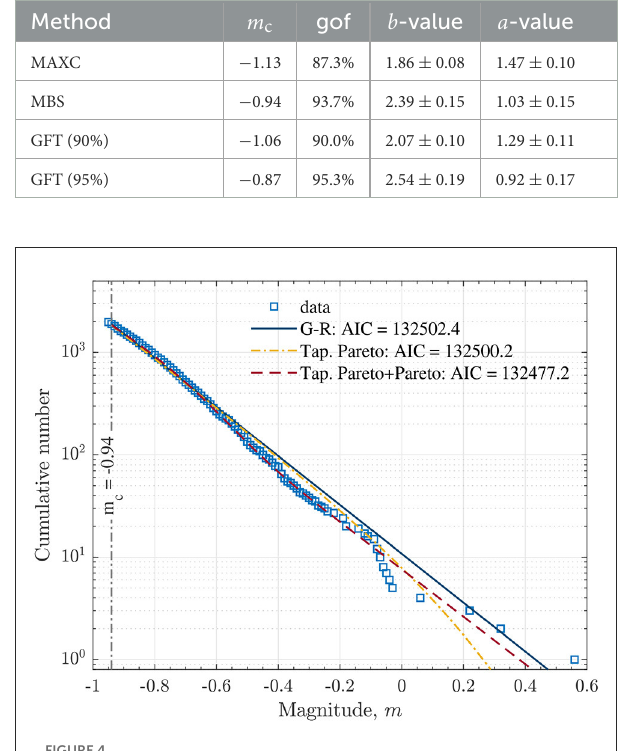
FIGURE4 The frequency-magnitude statistics for the mining-induced seismicity. The blue open squares represent the cumulative number of events. The dark blue line is the fit of the G-R scaling (3). The dash-doted line is the fit of the tapered Pareto distribution (9). The dashed line is the fit of the mixture of the tapered Pareto and Pareto distributions